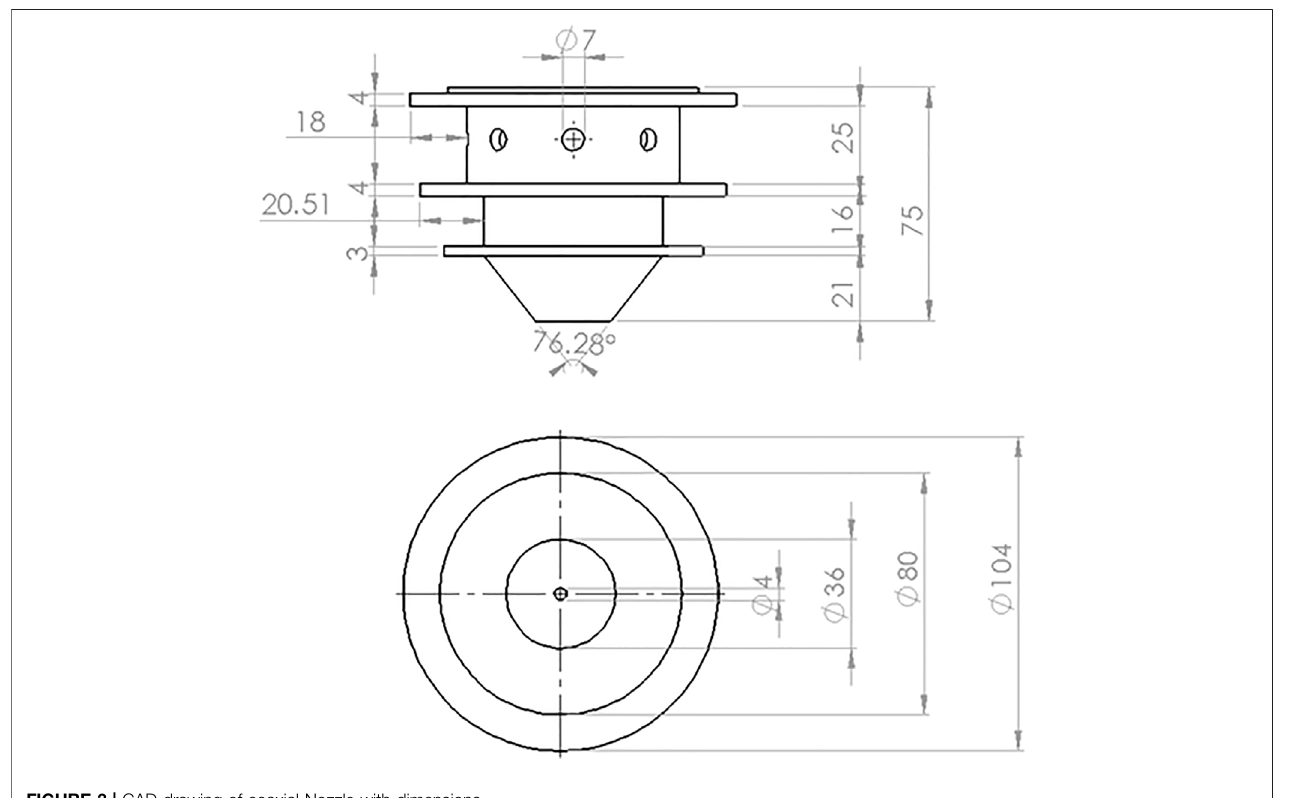
FIGURE 3 | CAD drawing of coaxial Nozzle with dimensions.